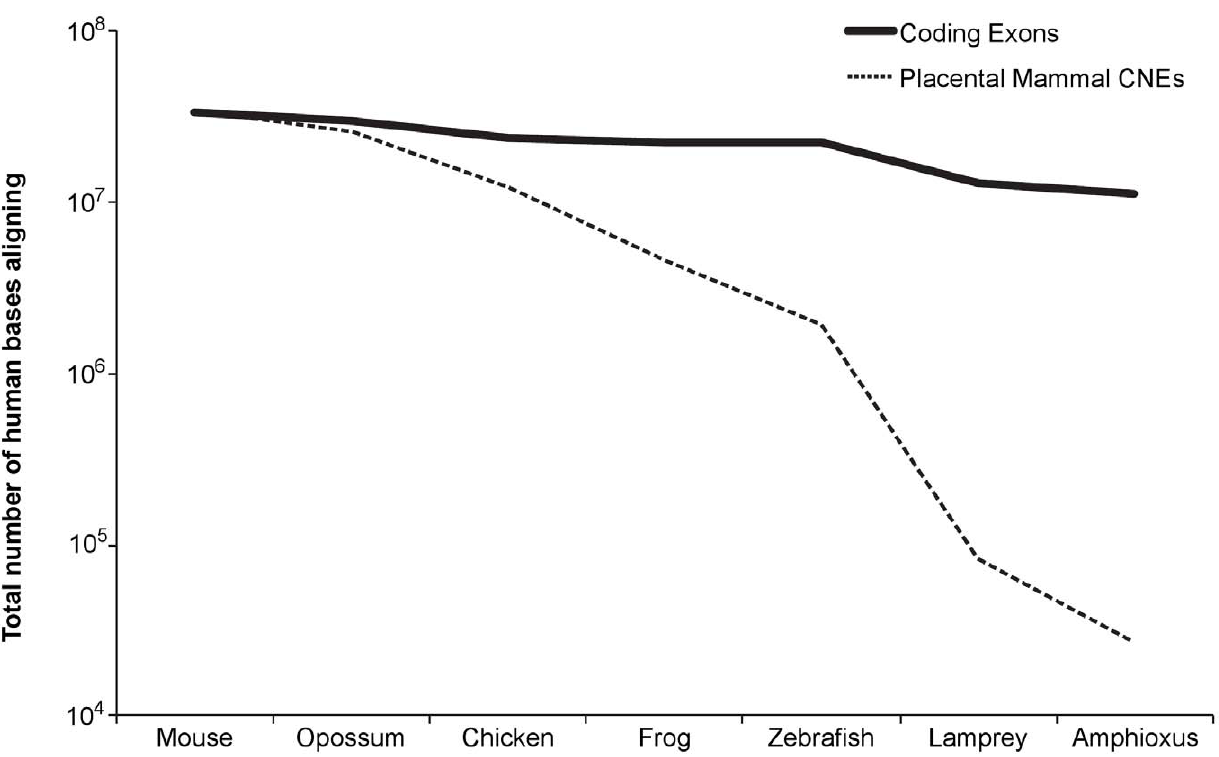
Figure 1. Total number of bases (coding versus conserved non-coding) in human that align to each species. Species are ordered at progressively greater evolutionary distances. Placental mammal CNEs – placental mammal conserved non-coding elements.